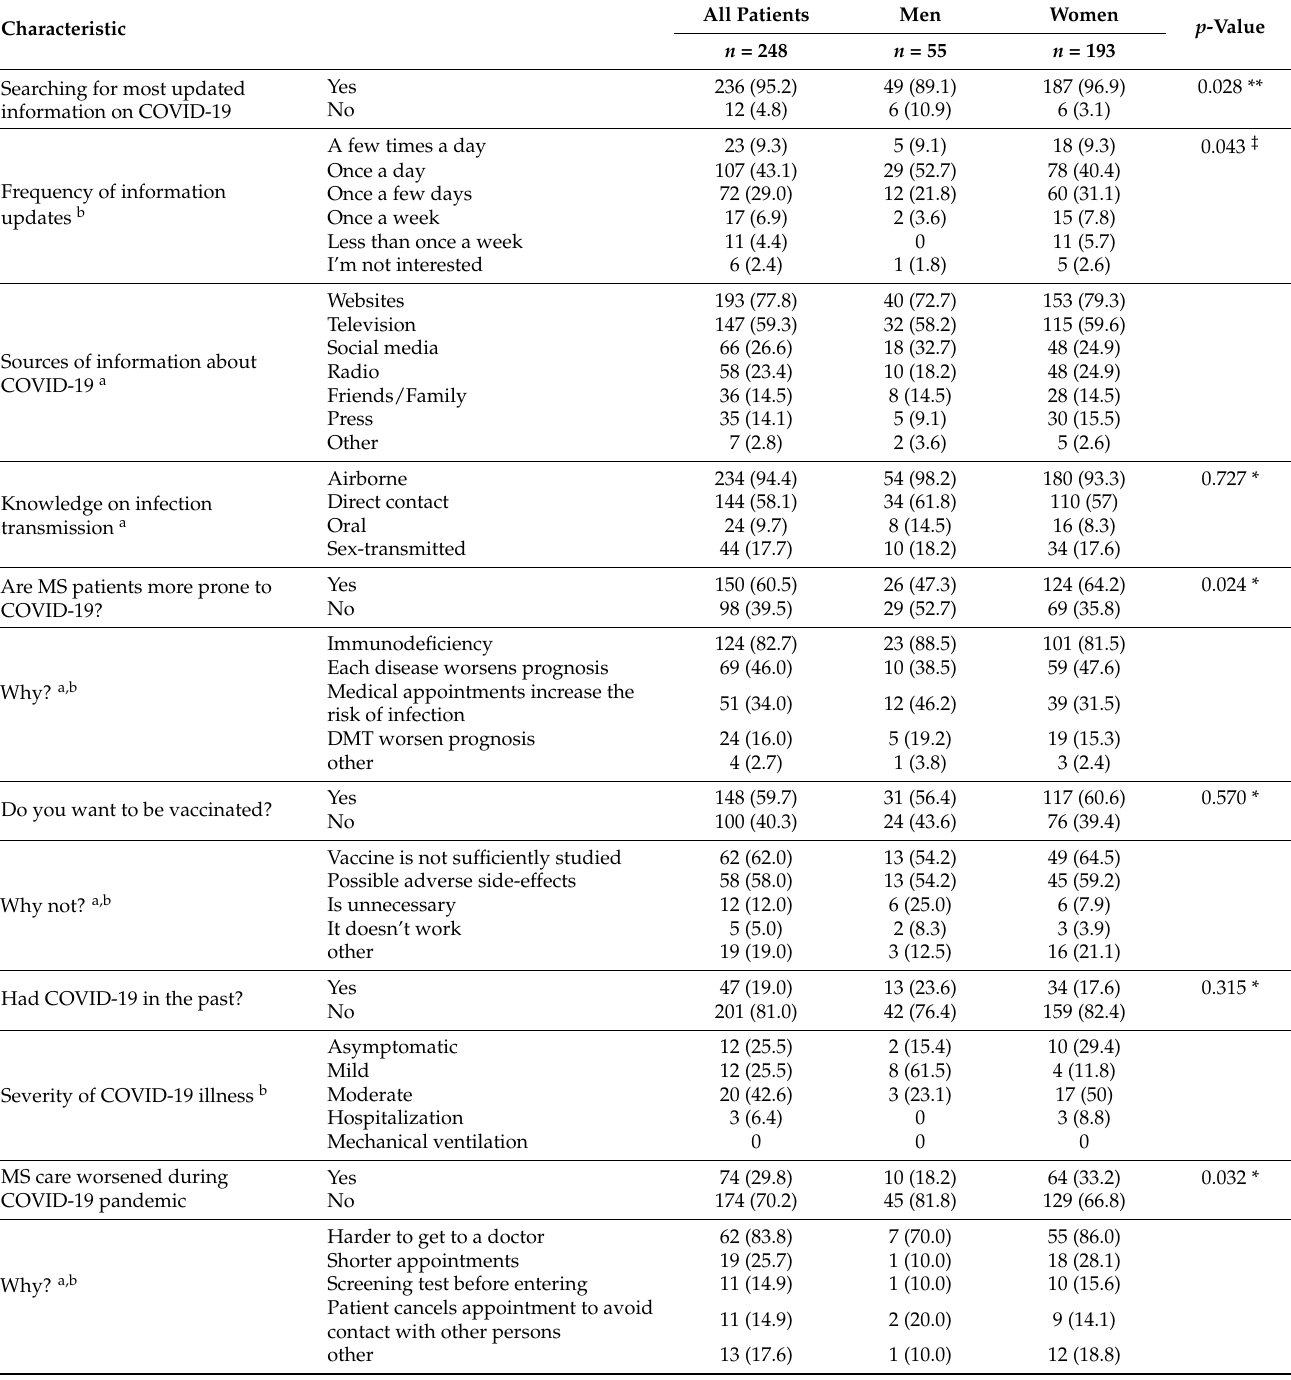
Table 2. Status of knowledge about COVID-19, SARS-CoV-2 infection, and vaccination willingness among MS patients, men and